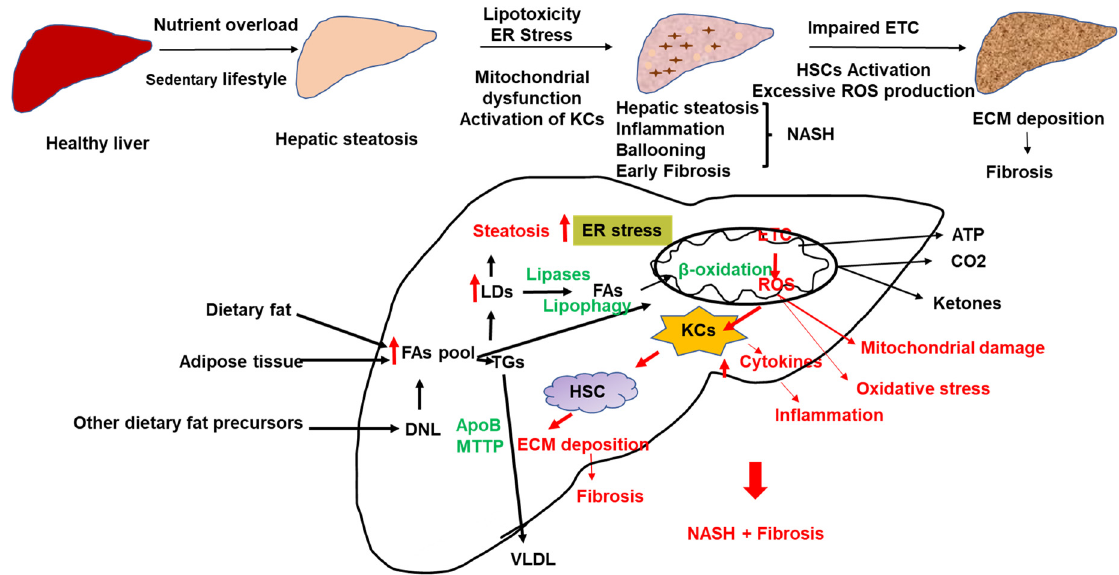
Figure 1. Pathogenic pathways involved in NAFLD. Top panel: schematic representing the progres- sion of NAFLD, and the factors involved. Hepatic steatosis results from nutrient overload and a sedentary lifestyle. Multiple factors lead to inflammation and NASH, and the progression to fibrosis. Bottom panel: mechanisms for the development and the progression of NAFLD. The pool of FAs in the liver originates from dietary fat, adipose tissue lipolysis, or de novo lipogenesis (DNL) from carbohydrates or other dietary precursors. Inside the liver, FAs are (1) esterified into TG and assem- bled into very-low-density lipoprotein (VLDL) to be secreted in the circulation, (2) oxidized in the mitochondria ( β -oxidation), or (3) stored in lipid droplets (LDs) (<5% of liver weight). LDs undergo lipid hydrolysis (via lipolysis and lipophagy) in fasting conditions to provide FAs for β -oxidation. With chronic nutrient overload and insulin resistance (increased adipose tissue lipolysis) in NAFLD, the input of FAs to the liver exceeds their disposal via VLDL secretion or β -oxidation. Lipotoxicity causes impaired LDs lipolysis and higher lipid accumulation in LDs (hepatic steatosis >5% of liver weight), leading to the endoplasmic reticulum (ER) stress, oxidative stress, and the activation of Kupffer (KCs) to produce inflammatory cytokines and inflammation. In addition, lipotoxicity causes mitochondrial dysfunction and impaired electron transport chain (ETC) function leading to ROS pro- duction. In a vicious cycle, ROS causes mitochondrial damage and aggravates NASH. Inflammation and ROS activate hepatic stellate cells (HSCs) to produce excessive extracellular matrix leading to progressive